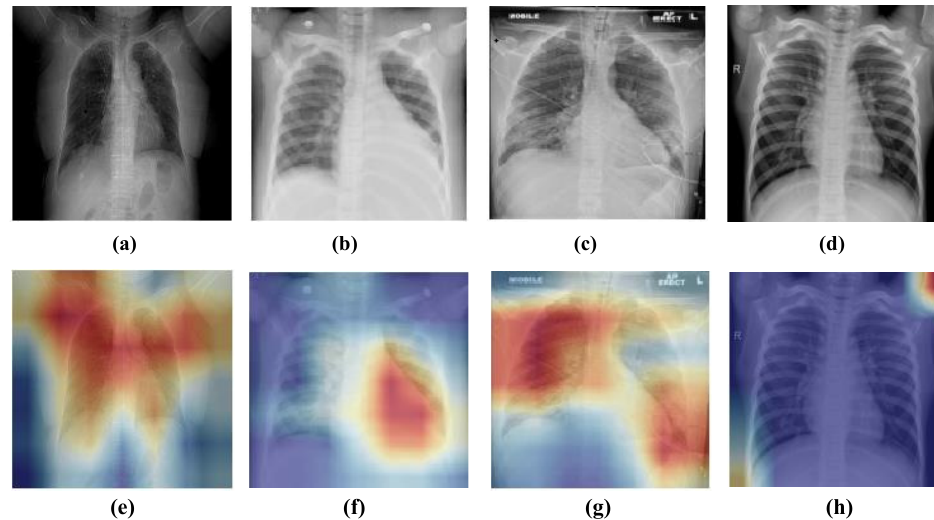
Figure 10. Grad-CAM visualization results of the proposed model on a few sample CXR images. ( a – d ) The top row indicates the original images. ( e – h ) The bottom row indicates the heat maps obtained by LW-CORONet.